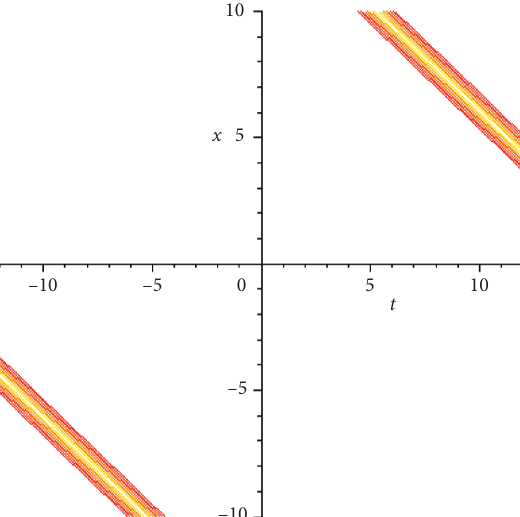
Figure 4: ψ ( x,t ) at c � 1 , v � − 1 , k � 1 , and α � 0 . 4 , 0 .